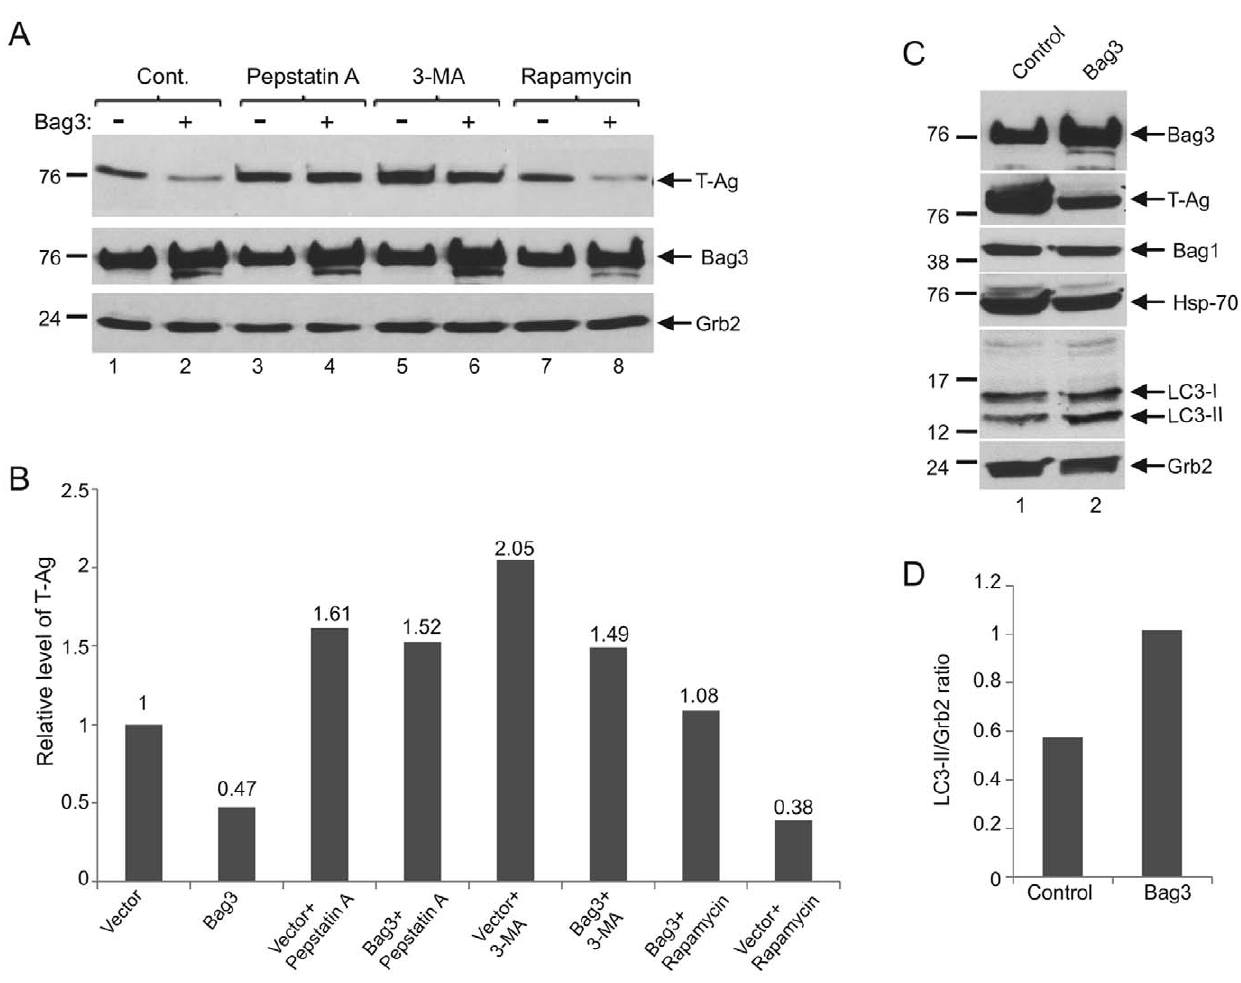
Figure 4. Autophagic degradation of large T antigen is induced by Bag3. A. BSB8 cells were transfected with an expression plasmid encoding Bag3, and treated either with pepstatin A, 3-MA, or rapamycin. Whole cell protein extracts were prepared at 48 hour post-transfection, and Western blot was performed for the detection of T-Ag, and Bag3 proteins. Western blot analysis of the same extracts with anti-Grb2 antibody was used as loading control. B. Relative intensity of the band corresponding to T-Ag from Panel A is shown as a bar graph. C. BSB8 cells were either transfected with control empty plasmid (lane 1) or expression plasmid encoding Bag3 protein (lane 2). Protein extracts were prepared at 48 hour post-transfection, and Western blot analysis was performed for the detection of Large T, Bag3, Bag1, Hsp70, LC3, and Grb2 proteins. D. Relative intensity of the bands corresponding to LC3-II seen in Panel C were determined by densitometry and after normalization to that from Grb2, illustrated as a bar